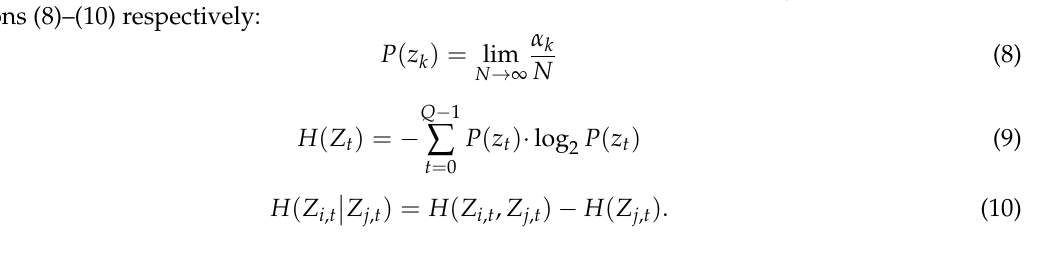
Figure 2. Spatial compressibility of CitySense temperature. 4.2. Modified Diffusion Wavelets Conventional CS-based data-gathering approaches generally assume that sensor node readings have perfect sparse features under FFT, DWT, DCT, etc. To make full use of the spatial correlation property, which is demonstrated by experiments in Section 4.1, we take diffusion wavelets [36] as the sparse basis considering the spatial correlation of sensor node readings in WSNs. One is the nodes degree, and the other is the distance between the different sensor nodes. In addition, an improved QR decomposition of Givens transform is introduced to set up the sparse basis. Then, we describe how to construct the modified diffusion wavelets in detail. However, diffusion wavelets are affected significantly by the diffusion operator, which is equivalent to the wavelet function of a discrete wavelet transform. Diffusion is utilized as a smoothing and scaling technique to enable multi-scale and coarse-grained application. The detailed steps are shown in Algorithm 1. Step 1: Suppose that ( , ) G V E denotes a graph with N sensor nodes deployed in the monitoring environment, as indicated in Section 3.2. Diffusion wavelets are introduced to set up an orthonormal basis for functions supported by the topology graph of WSNs. In this section, we take a random deployment of WSNs to explain this process. WSNs ’ topology of 640 sensor nodes is shown in Figure 3. In Figure 3, the hexagram vertex represents the sensor node, while the blue edge denotes the wireless link.